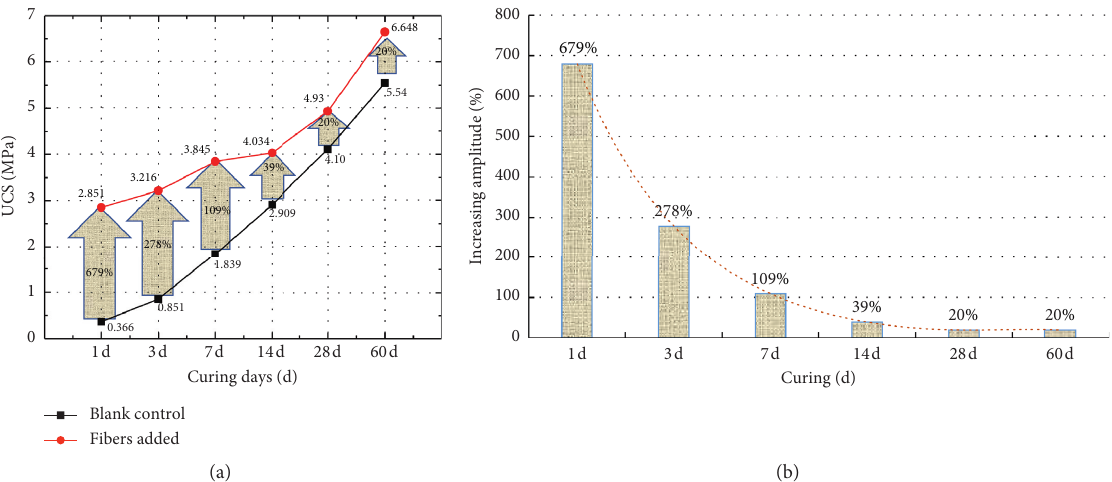
Figure 11: Comparison of the compressive strength improvement. (a) Comparative analysis of the mechanical strength improvement. (b) Histogram of the mechanical strength